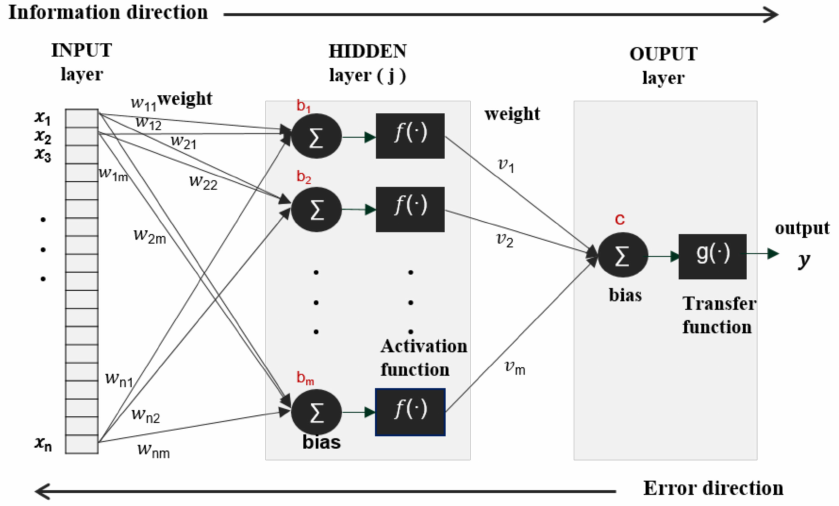
Figure 4. The structure of the artificial neural network (ANN) based on multi-layer